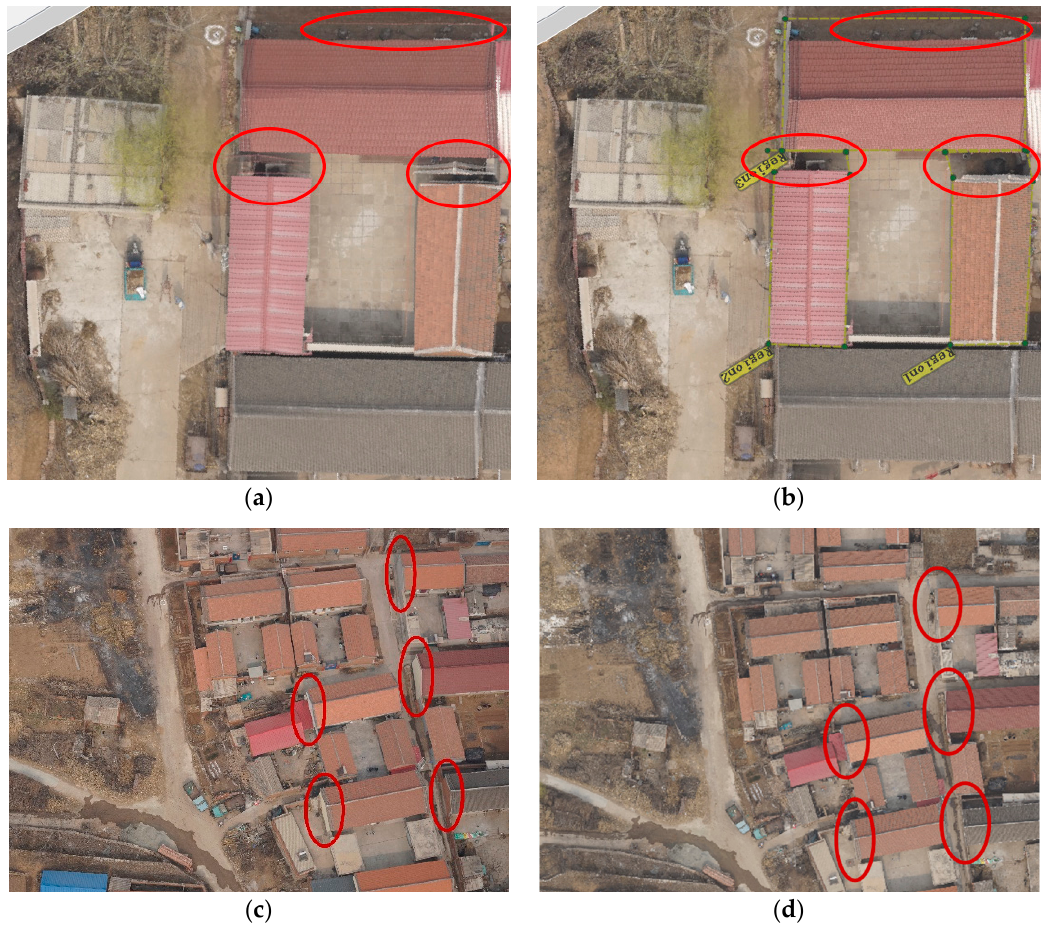
Figure 8. ( a ) Original DOM of the test area A; ( b ) TDOM of the test area A after multi-view image compensation; ( c ) original DOM of the test area B; and ( d ) TDOM of the test area B after multi-view image compensation.